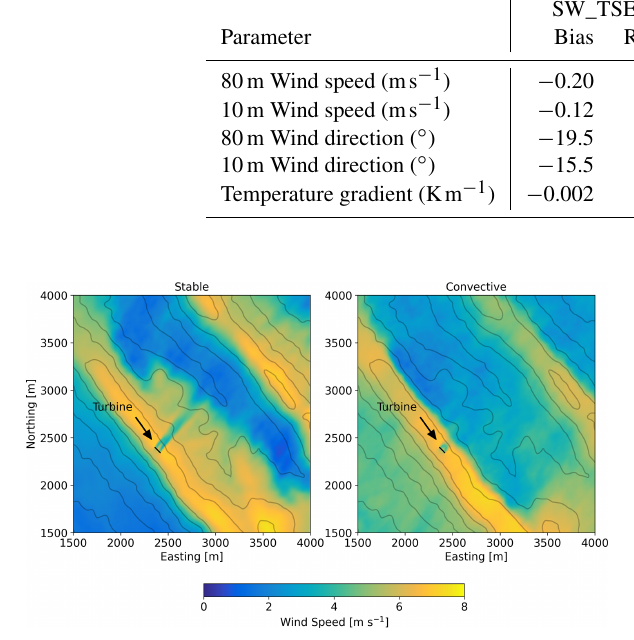
Figure 11. One-hour time-averaged wind speed contours at 80m above the terrain for the stable case study and for the convective case study. Line contours represent 50m changes in